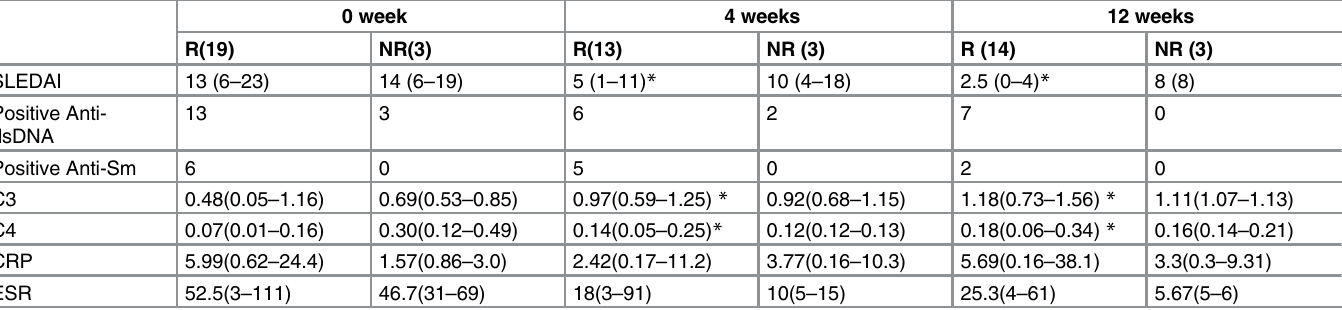
Table 2. Stratification analysis of the clinical measures in patients following regular therapy for